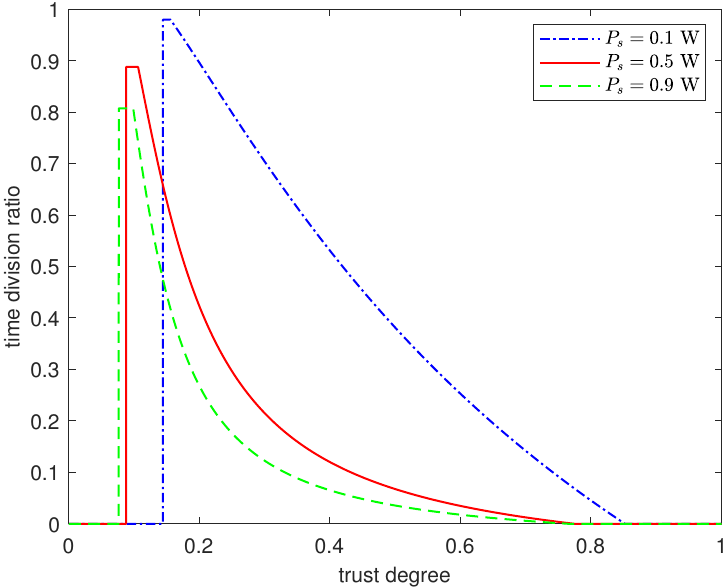
Figure 5. Time division ratio versus trust degree.